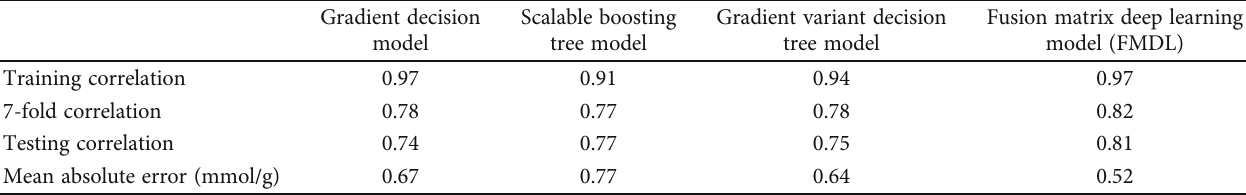
Table 5: Evaluation of the tree machine learning models using the benchmark data, the gradient decision model (GDM), the scalable boosting tree model (SBT), and gradient variant decision tree model (GVD) and our proposed model fusion matrix deep learning model